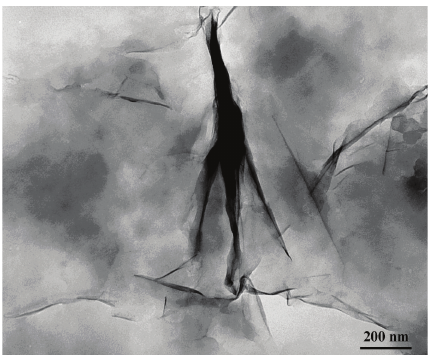
Figure 2: Transmission electron microscopy image of neat nan- oclay.